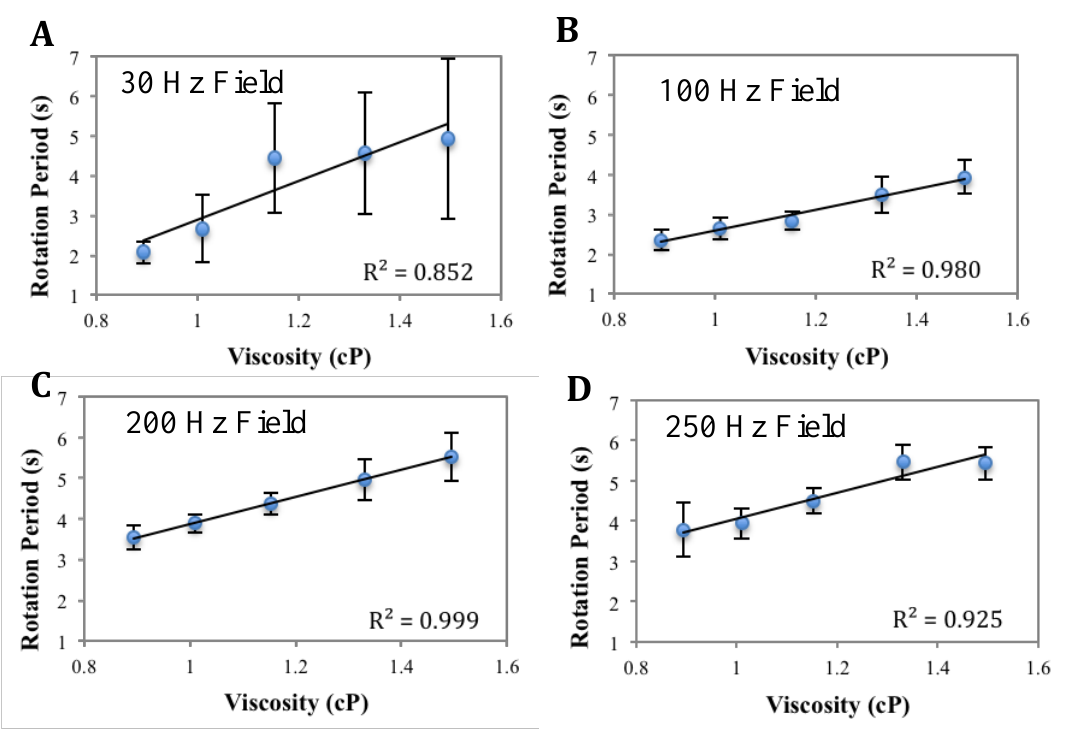
Figure A2. Calibration curves of 45µm bead at different driving frequencies. A : 30 Hz; B : 100 Hz; C : 200 Hz; D : 250 Hz. The critical frequency is at 10–15 Hz. The error bars represent the standard deviation among ten different beads in one measurement. The calibration curves yield good linearity consistently at frequencies away from the critical frequency, i.e ., from 100 Hz to 250